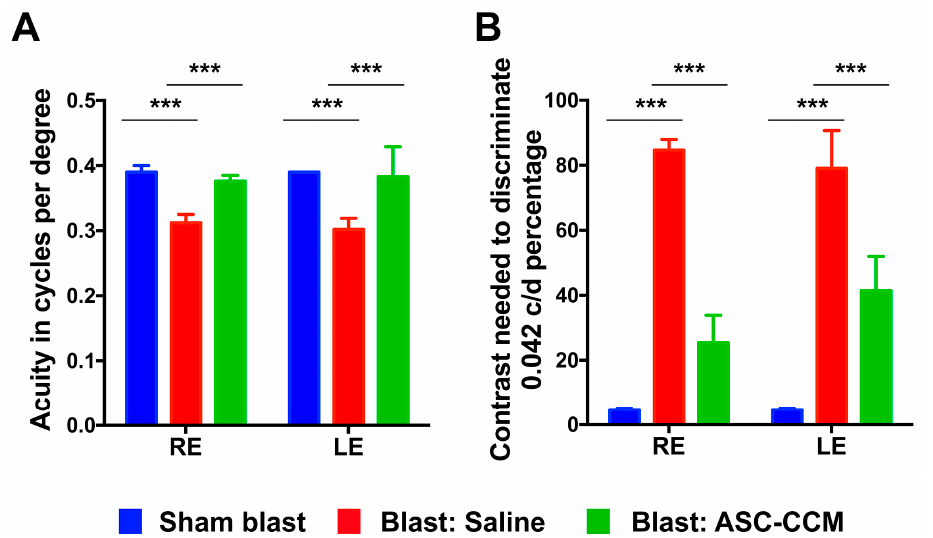
Figure 3. ASC-CCM improves visual acuity and contrast sensitivity in blast injury mice. ( A ) Visual acuity was measured by presenting black and white bars of varying spatial frequencies at 100% contrast ( B ) Contrast sensitivity was measured by changing the contrast gradient that generates tracking at a fixed spatial frequency of 0.042 c/d. Contrast sensitivity in mice is expressed as a percentage, with a higher percent contrast requirement indicating less contrast sensitivity. Data represent Mean ± SEM from n = 8–10 animals/group. ***, p < 0.001.